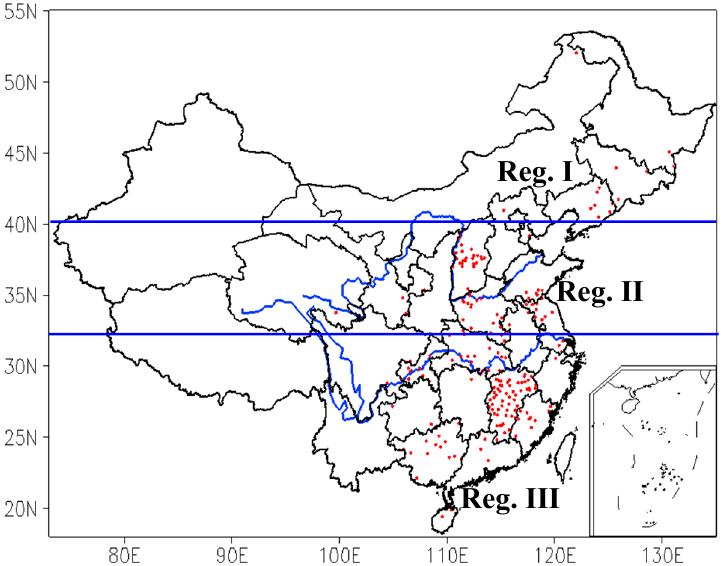
Figure 2. Spatial distribution of the 208 hydrological stations (red points). The two blue lines correspond to the annual 800-mm and 400-mm precipitation contours, which are used to divide China into three sub-regions: Reg. I, Reg. II and Reg. III.